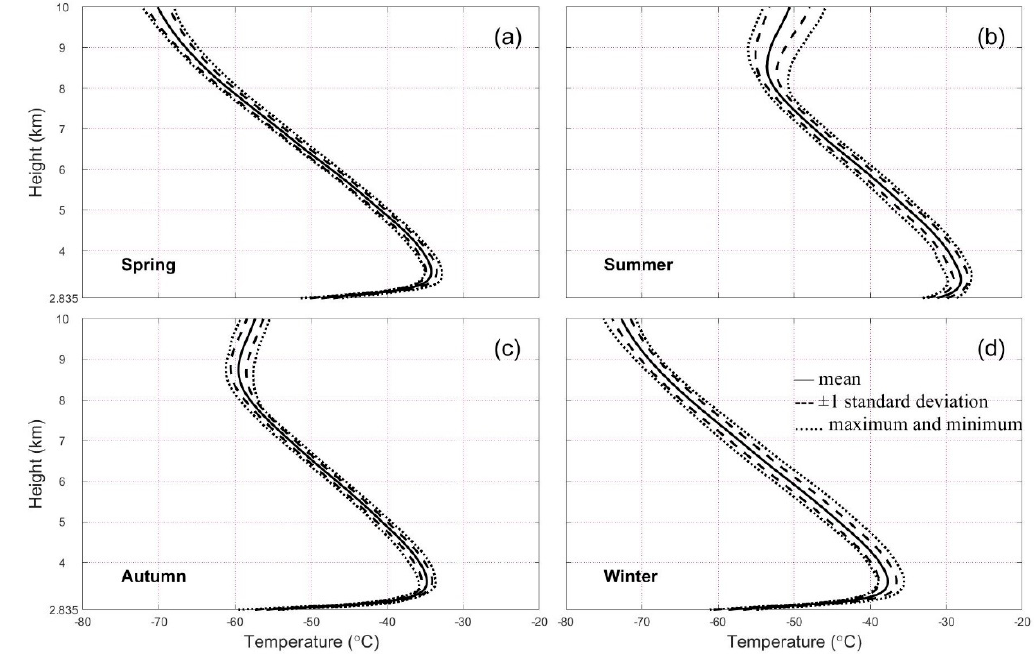
Figure 2. Temperature profiles for ( a ) spring, ( b ) summer, ( c ) autumn and ( d ) winter from Amundsen–Scott radiosonde profiles during 2005–2018. The long-term seasonal mean is indicated by the solid lines and ± 1 standard deviations are shown as the dashed lines, while maximum and minimum temperatures are represented with dotted lines.